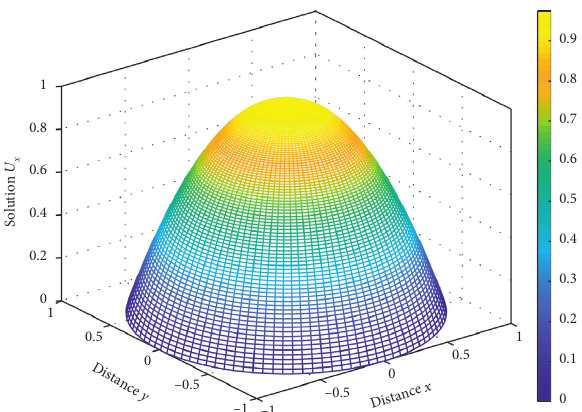
Figure 9: The exact solution.